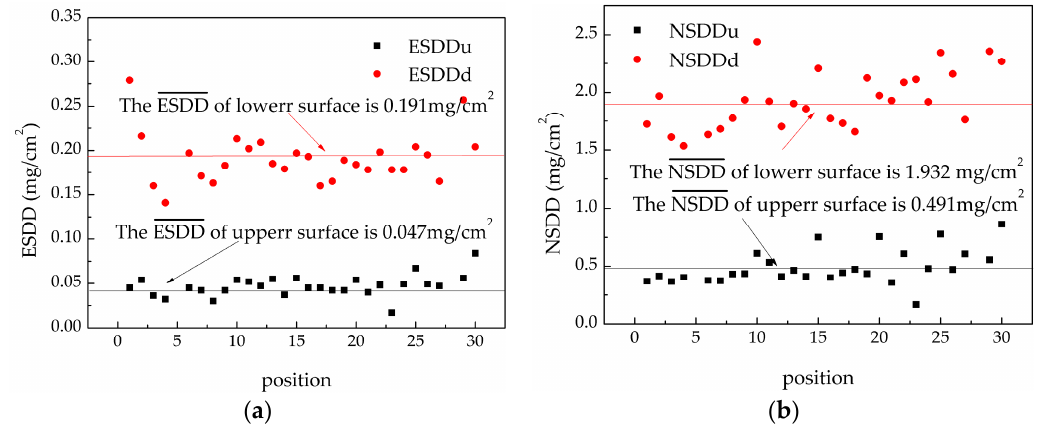
Figure 8. The contamination of HVDC( − ). ( a ) The results of ESDD. ( b ) The results of NSDD.